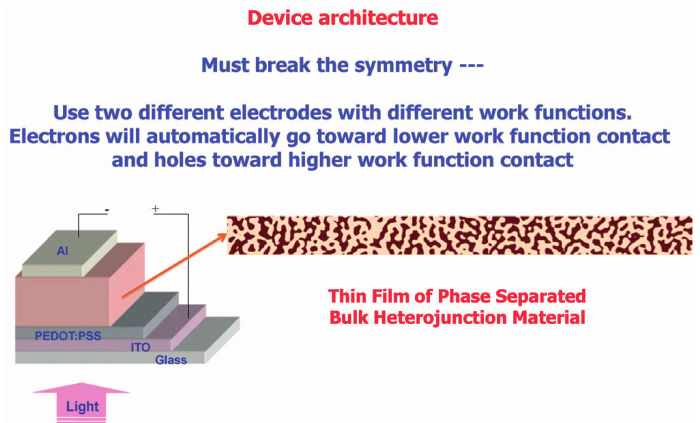
Figure 6. Conventional device architecture of the bulk heterojunction solar